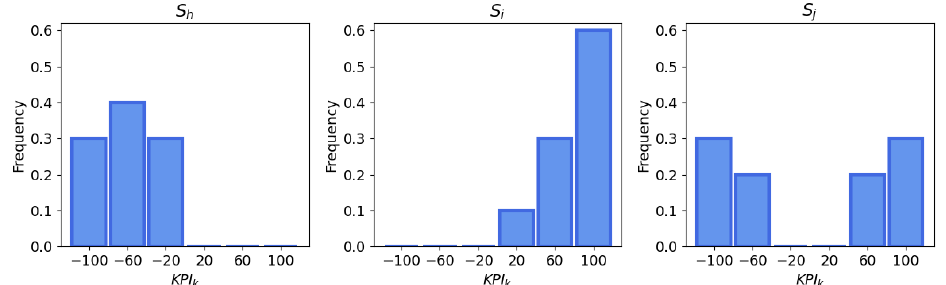
Figure 3. Three different stores represented as univariate histograms. KPI values are on the x-axis, and their relative frequencies are on the y-axis.